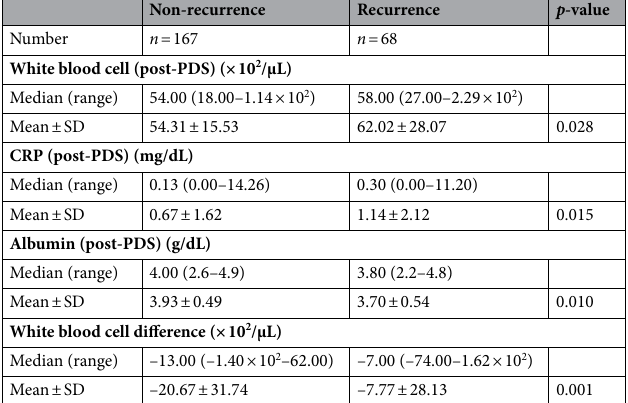
Table 4. Post-PDS peripheral blood cell and serum markers. CRP C-reactive protein, PDS primary debulking surgery.